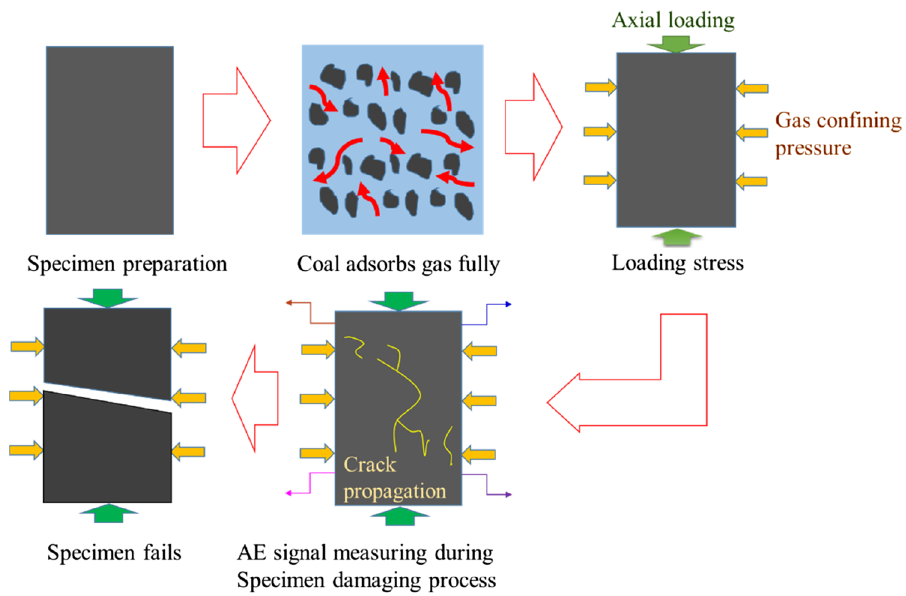
Figure 5. Flow chart of experimental process under load until the gas-bearing coal